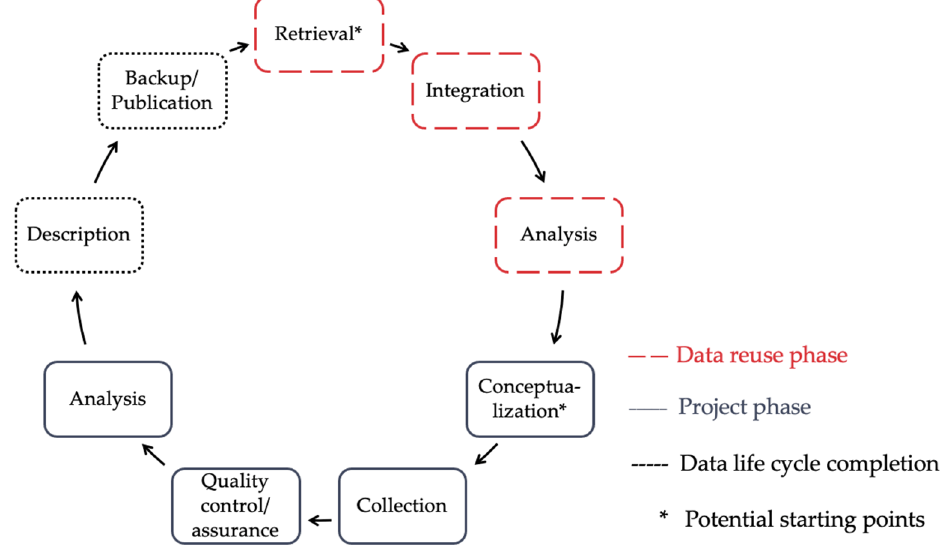
Figure 1. The data life cycle, suggested by Rüegg et al. [27] , own illustration.